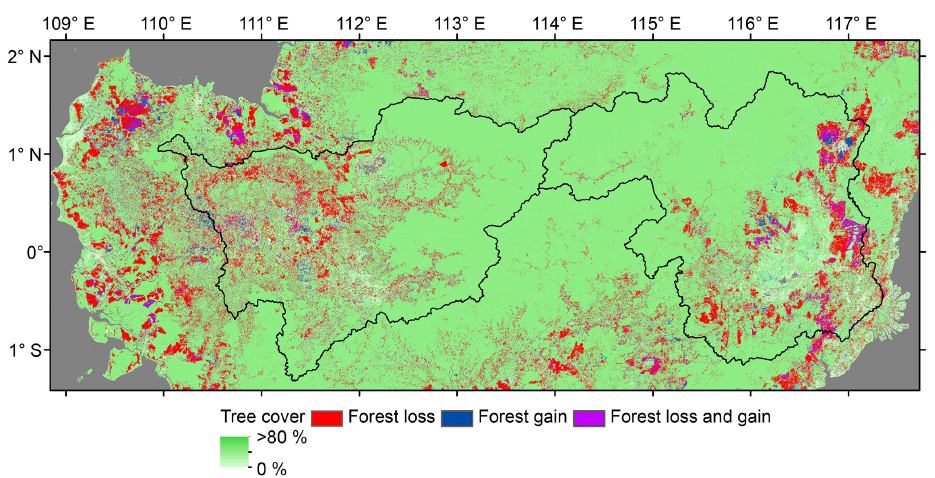
Figure 14. Tree cover (green) forest loss (red) forest gain (blue) with loss and gain (purple) between 2000–2012 in the Kapuas and the Mahakam. Data source: Global Forest Change (Hansen et al.,